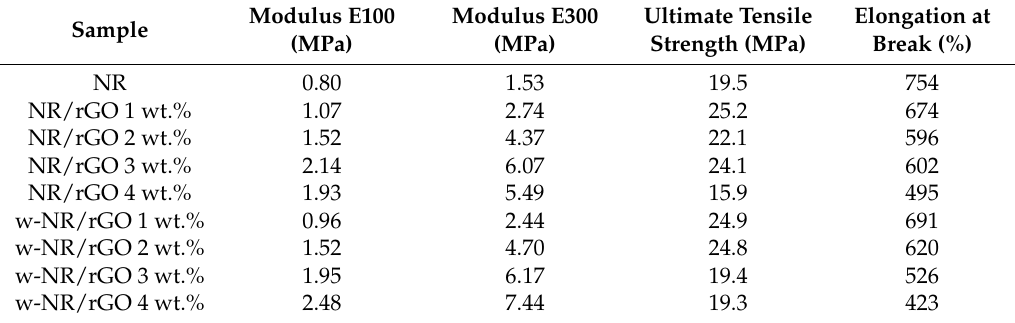
Table 1. Modulus at 100% and 300% of elongation, ultimate tensile strength and elongation at break of NR/rGO and w-NR/rGO